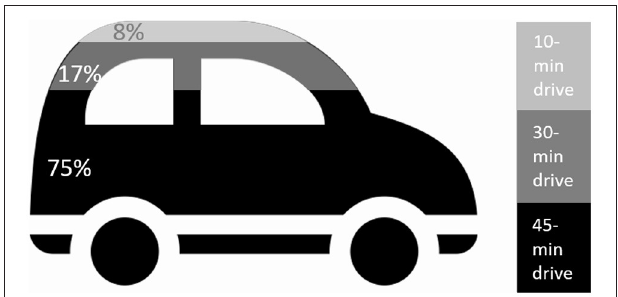
FIGURE 3 | Willingness of informal caregivers to drive the patients specifically for training sessions with the robot. One hundred percent of the participants in the informal caregivers’ groups drive their family members to errands and treatments. One hundred percentage of them indicated that they will be willing to drive them specifically for training sessions with the robot, with 92% of them willing to drive 30–45min for that